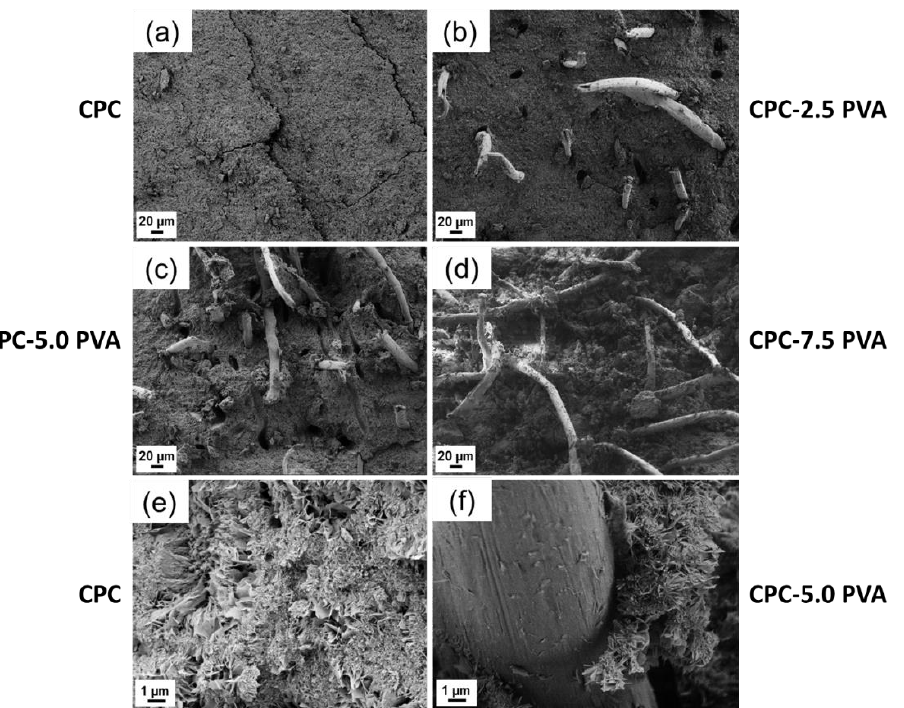
Figure 5. SEM micrographs of fractured surfaces of the cements. ( a ) Group CPC (0 wt % PVA); ( b ) group CPC-2.5 PVA (2.5 wt % PVA); ( c ) group CPC-5.0 PVA (5 wt % PVA); ( d ) group CPC-7.5 PVA (7.5 wt % PVA). ( e ) Group CPC and ( f ) group CPC-5.0 PVA at different magnifications.